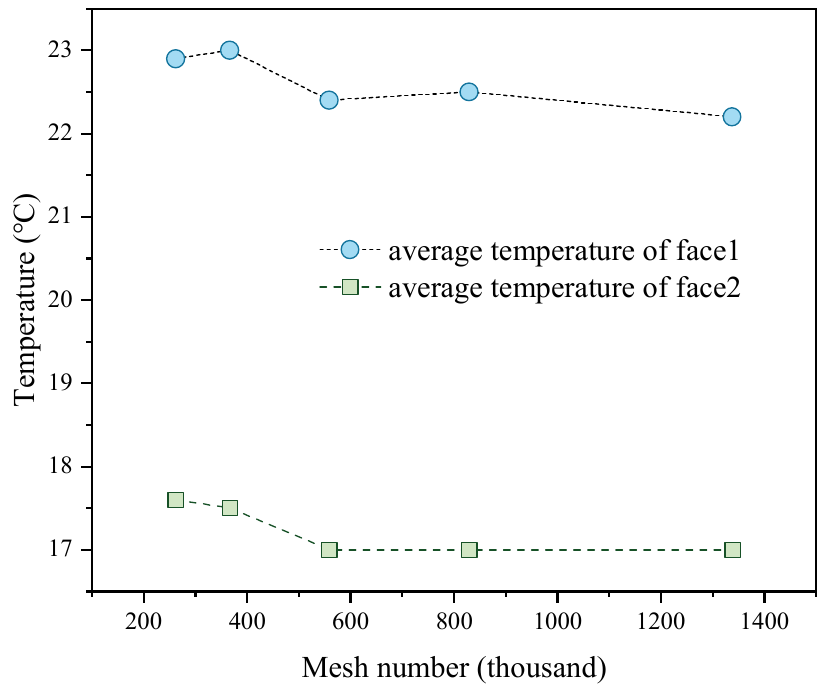
Figure 5. Grid independence verification results. A field test was conducted to verify the accuracy of the model. The measured parame- ter was the air temperature at the inlet and outlet of the first rack in column F, as shown in Figure 6a, which is a photograph of thermocouple arrangements at the outlet of the rack. Figure 6b is the schematic of the thermocouple arrangement. There were 21 thermocouples arranged in the inlet and outlet, respectively, divided into seven layers, with three evenly arranged in each layer. Their average temperature was calculated. The test process lasted for about 5 h, because the air supply parameters of the CRAHs varied during the test, and the measured data also fluctuated in response. We finally selected a relatively stable period of temperature data as the validation data to test the accuracy of the model. The thermocouple is an OMEGA brand K-type thermocouple, whose accuracy is ± 0.1 K after calibration, and the acquisition equipment used was Agilent 34972A. The temperature of the CRAHs outlet was also measured using the above equipment, and the airflow rate of the outlet was measured using an anemometer, whose accuracy is ± 0.3 m/s. The measured temperature of the outlet was 14 ◦ C, and the speed was 2.7